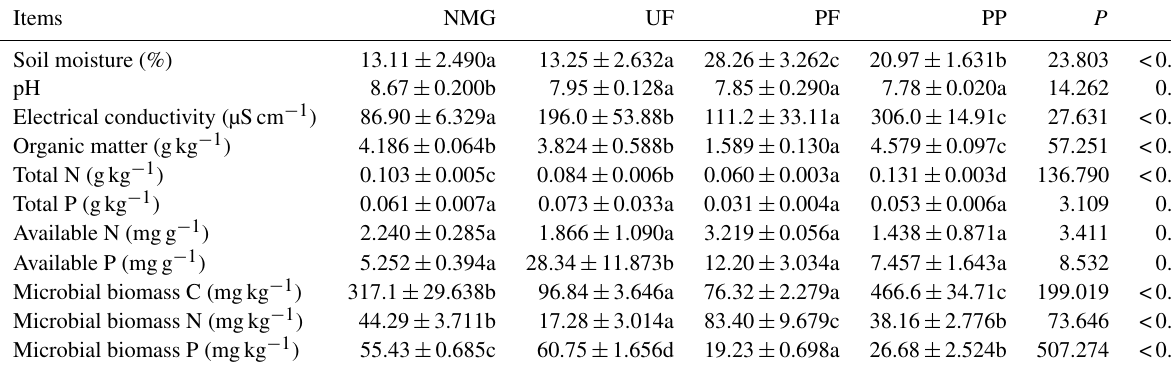
Table 1. Soil pH, EC, nutrients, and microbial biomass of samples (average of three replicates ± SD). Items